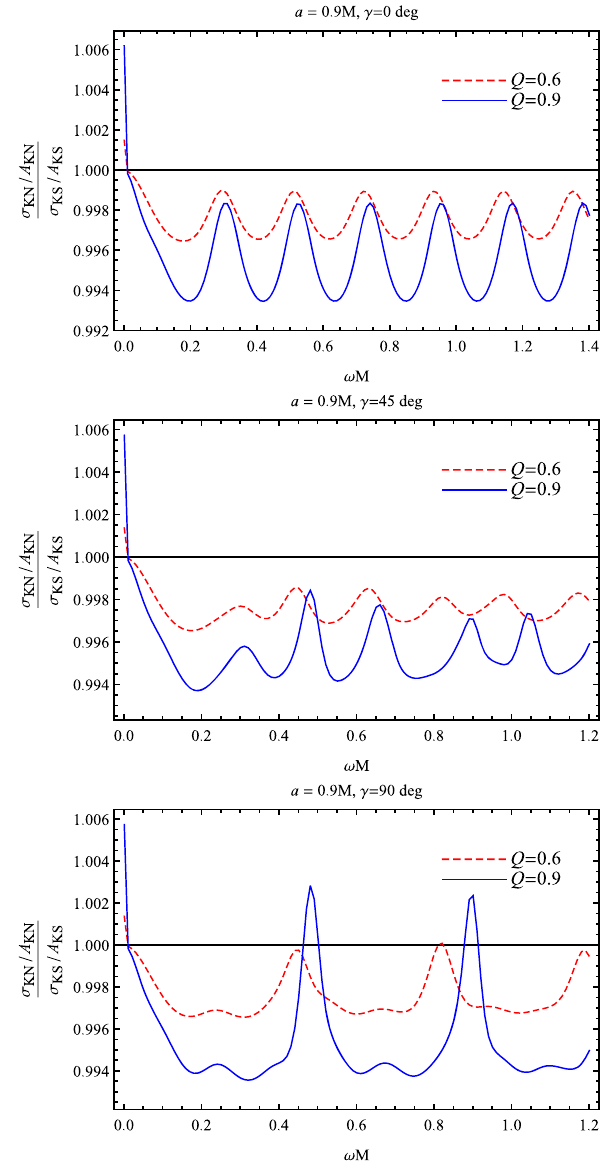
Fig. 8 Ratio between the absorption cross section and the areas of the black holes for a wave with incidence angle γ = 0 deg (top), γ = 45 deg (middle) and γ = 90 deg